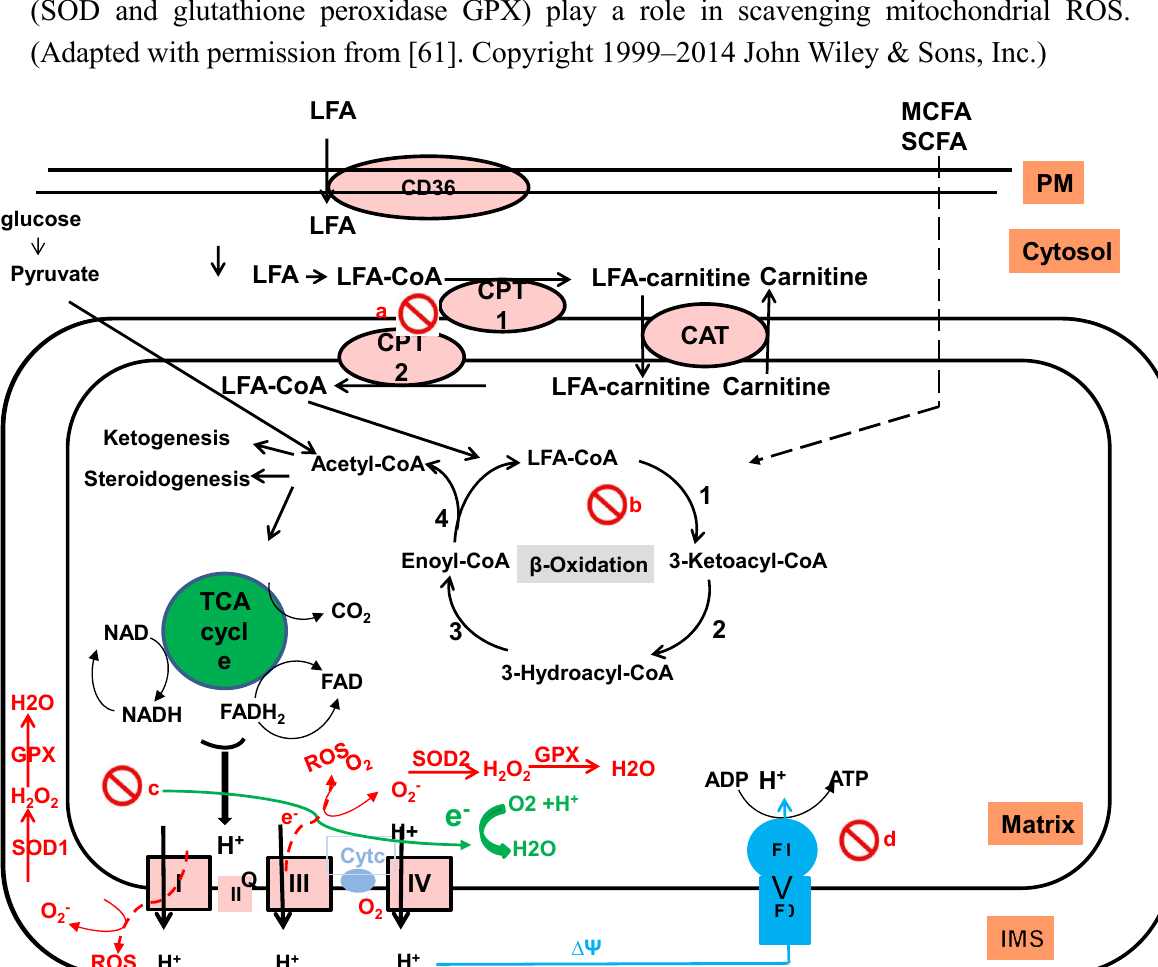
Figure 2. Hepatic β -oxidation: Mitochondrial β -oxidation involves four